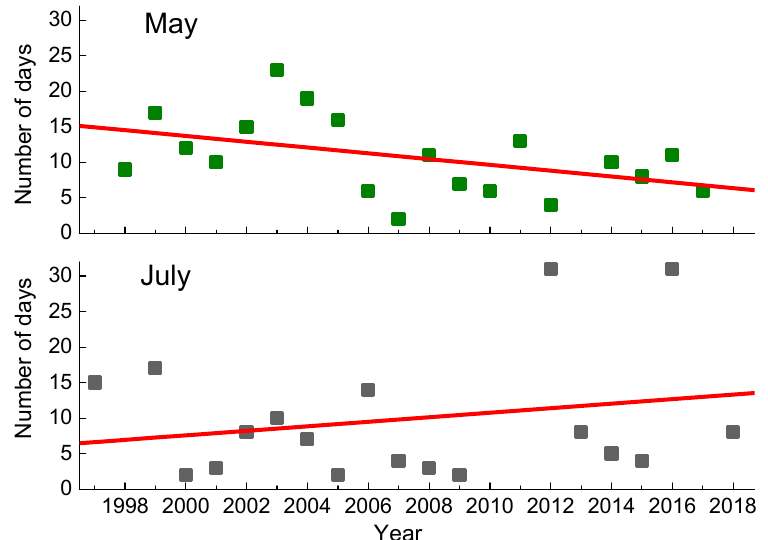
Figure 3. Time behavior of the number of days in May and July with the effect of smoke from forest fires, based on measurements from the Aerosol Station from 1997–2018. Straight lines show linear regressions.